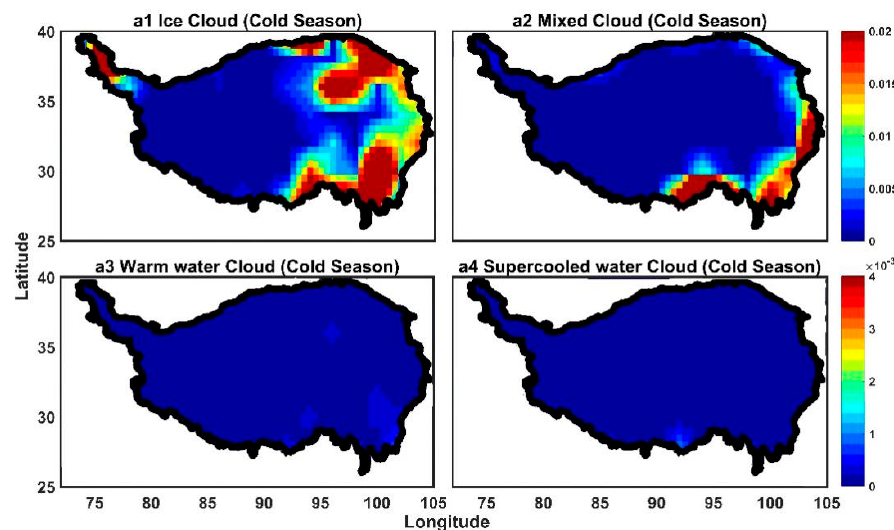
Figure 9. Precipitation frequency of the different cloud phases during the cold season ( a1-a4 represent ice, mixed-phase, warm water, supercooled water clouds, respectively).